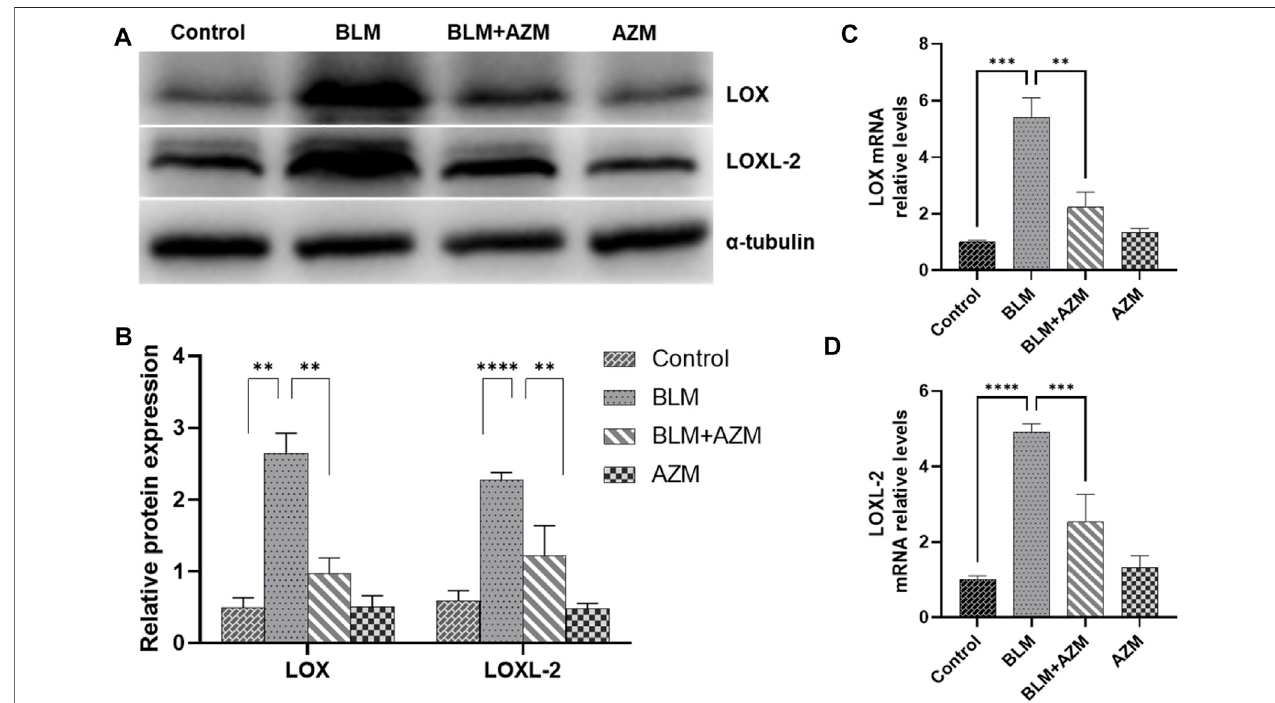
FIGURE 3 | AZM reduced the expression of lysyl oxidase (LOX) and lysyl oxidase-like protein (LOXL2) in lung tissue of mice with pulmonary fi brosis. (A,B) The proteinrelativeexpressionofLOXandLOXL2wasmeasuredineachgroupbyWesternblot. (C,D) ThegeneexpressionofLOXandLOXL2wasmeasuredineachgroup by RT-PCR. Data were presented as the means ± SD ( n ≥ 3). ** p < 0.01, *** p < 0.001, **** p <